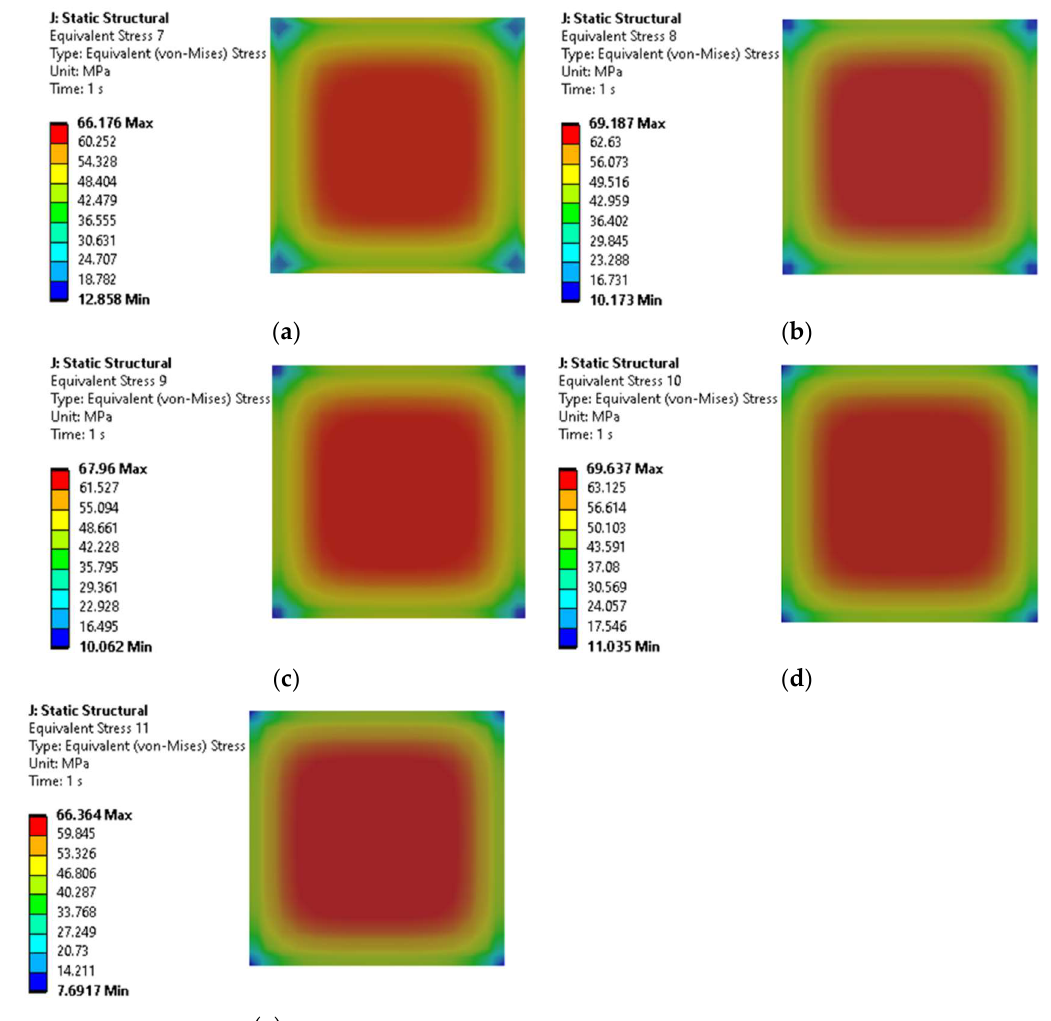
Figure 6. Residual stress profile in the BC: ( a ) 310 µm, ( b ) 370 µm, ( c ) 430 µm, ( d ) 490 µm y, and ( e ) 550 µm.